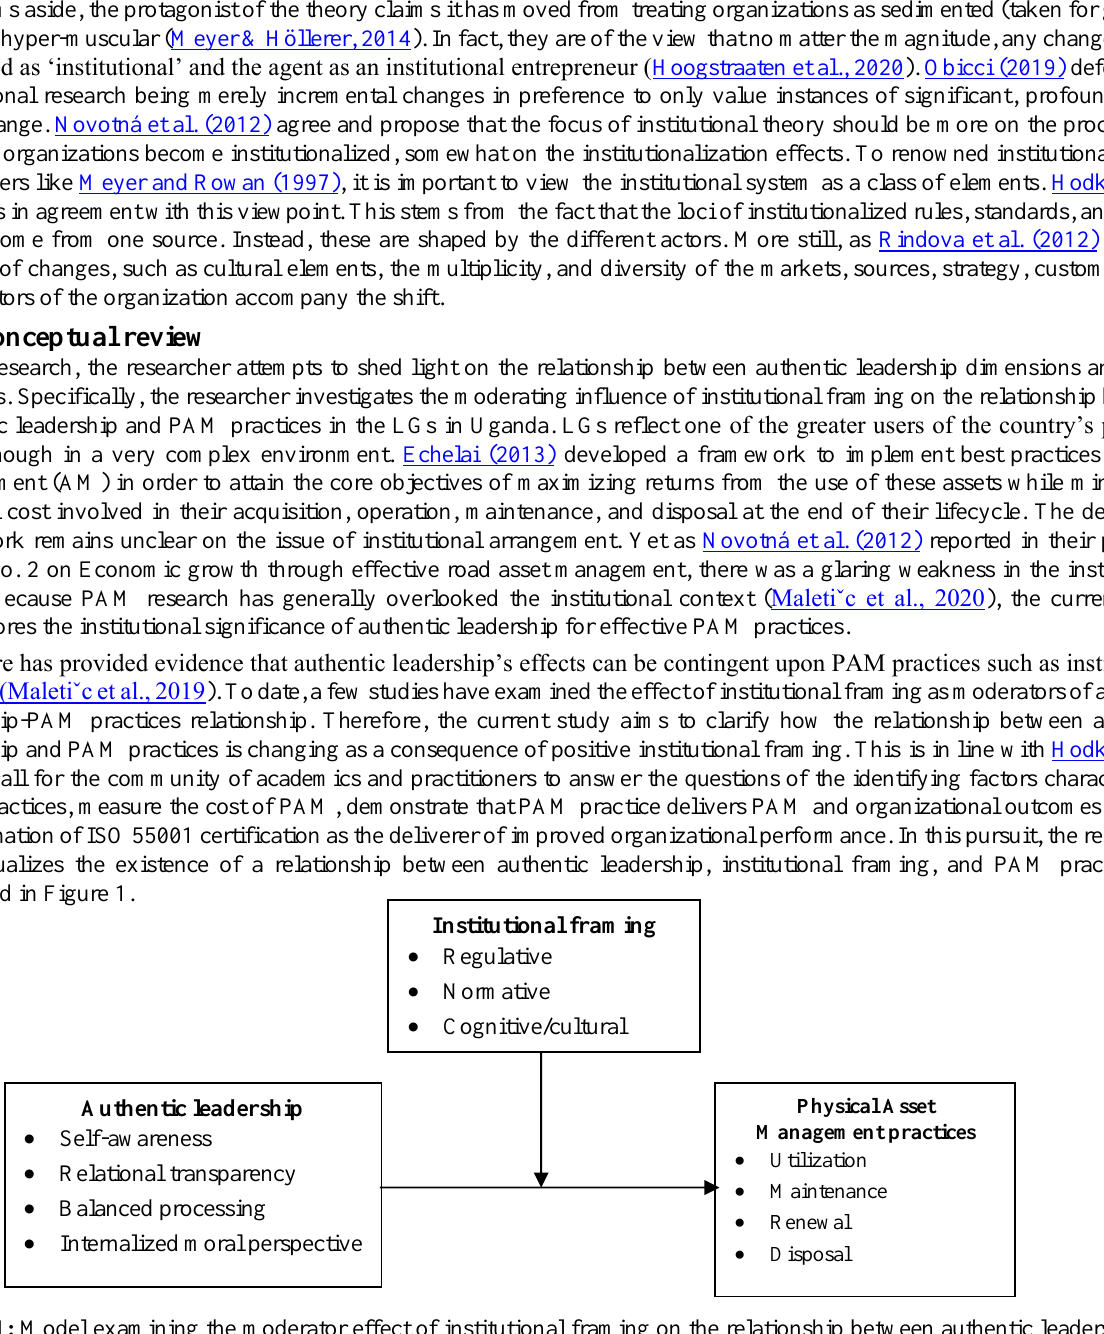
Figure 1: Model examining the moderator effect of institutional framing on the relationship between authentic leadership and PAM